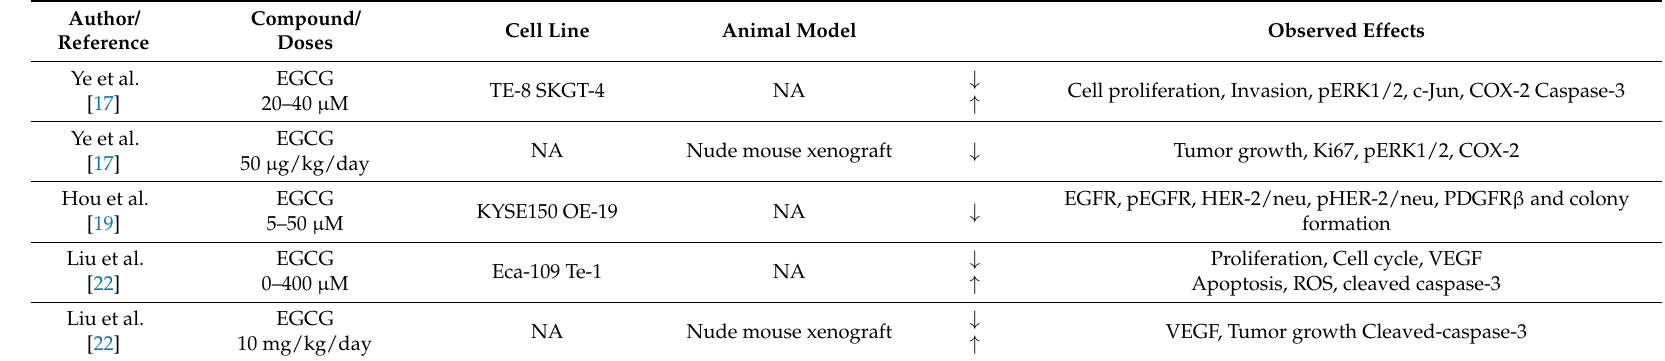
Table 3. Anticancer effects of green tea and its bioactive constituents on EC in in vitro and in vivo